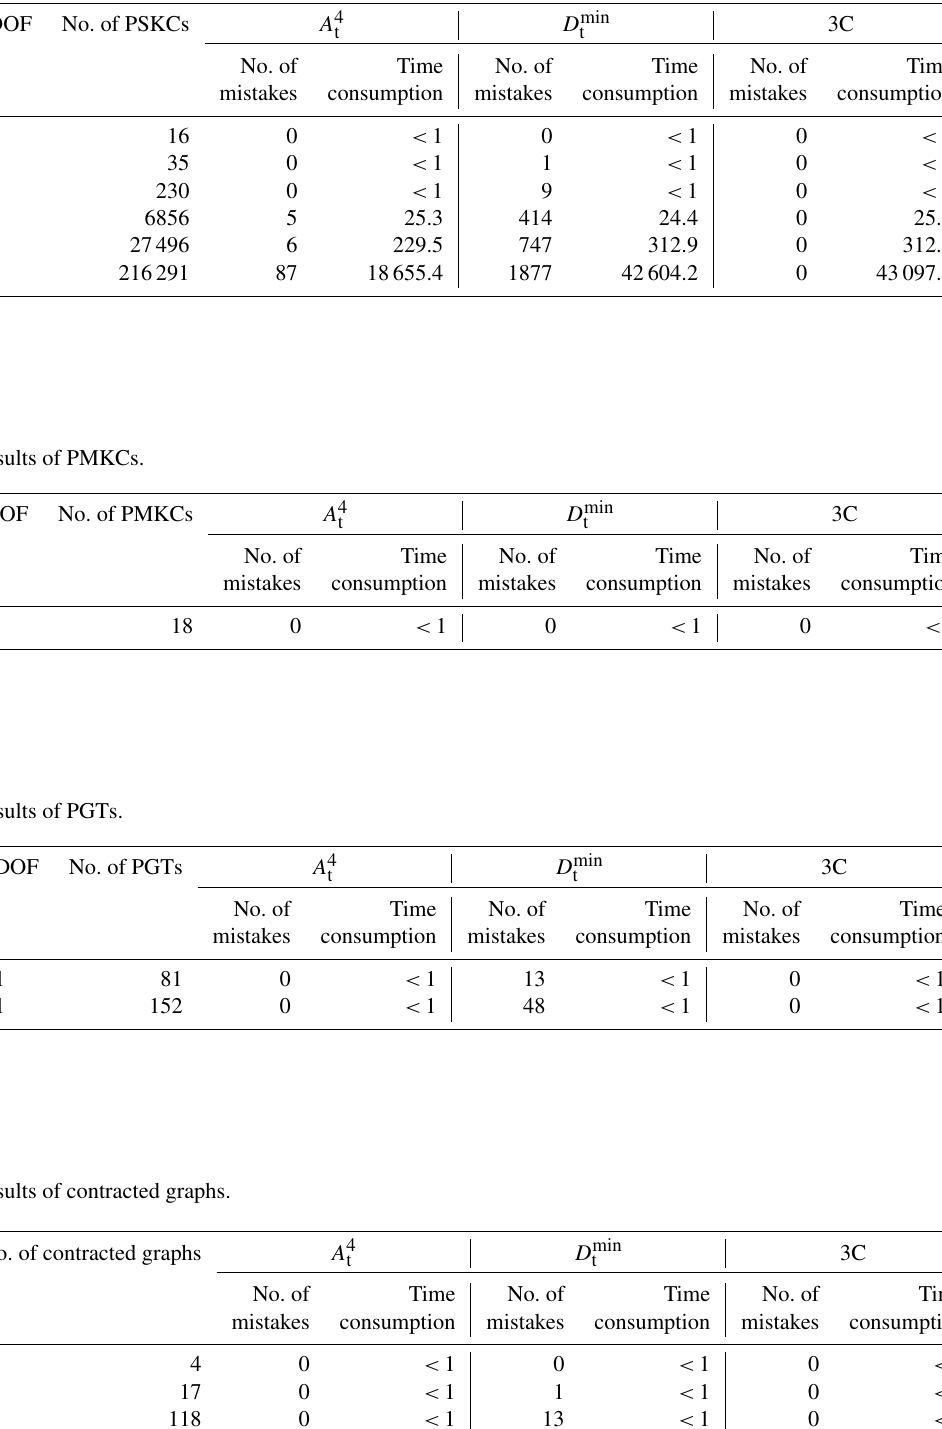
Table 1. Detection results of PSKCs.